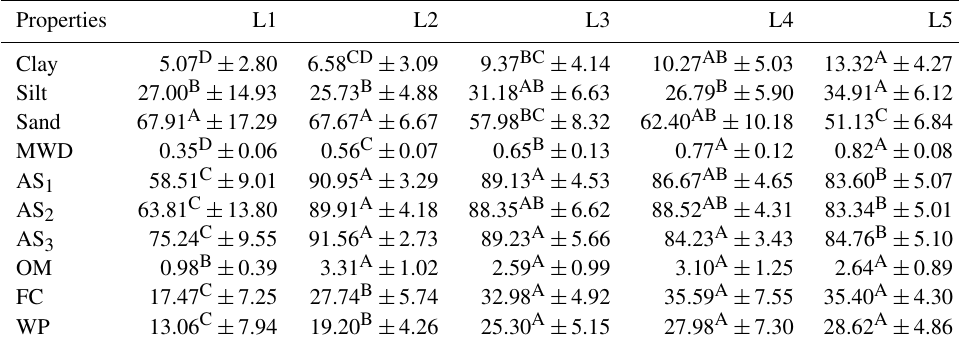
Table 5. Summary of ANOVA for soil properties. Properties